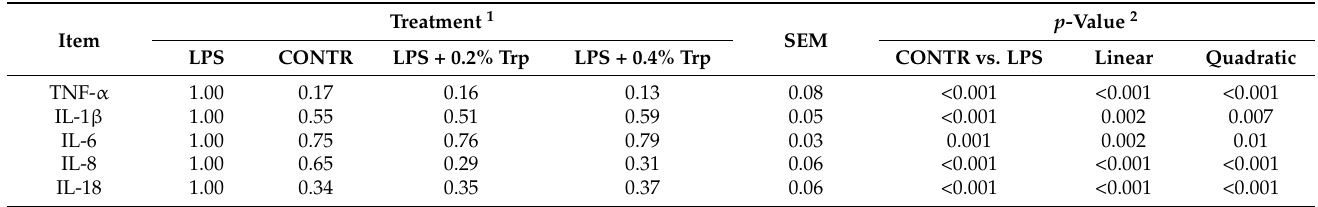
Table 6. Impact of tryptophan on the ileal proinflammatory cytokines-related gene expressions after 4 h LPS challenge in piglets.